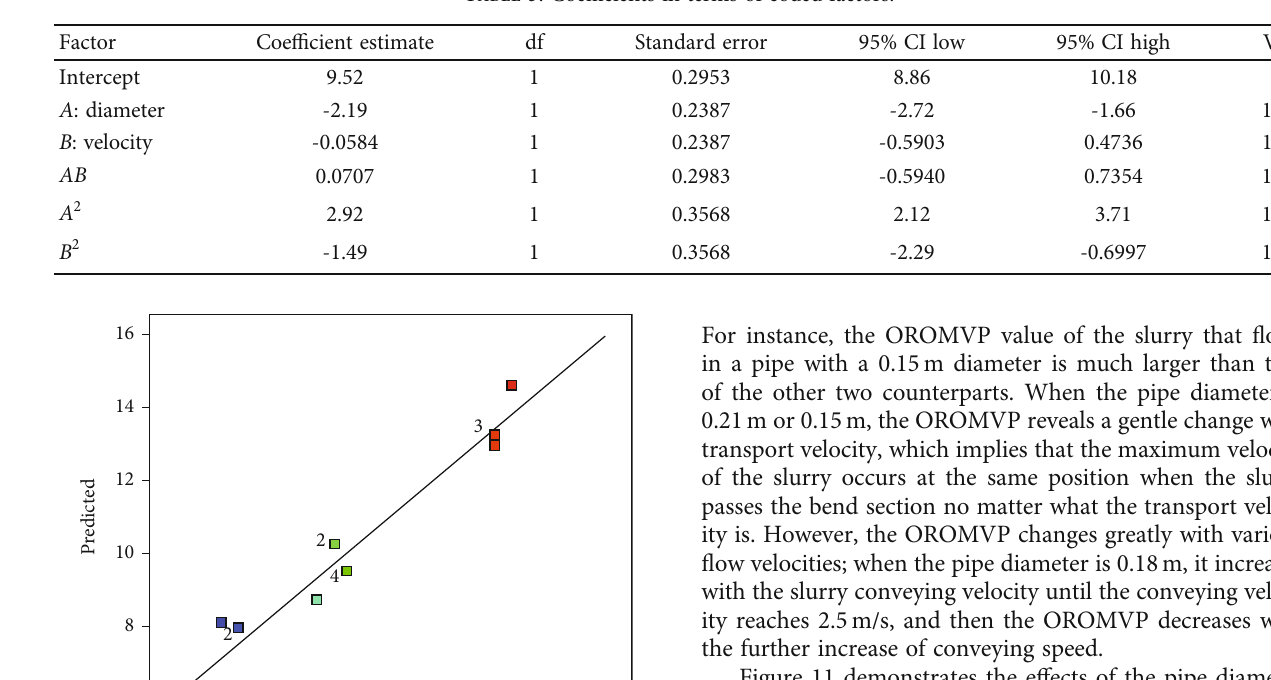
Table 5: Coe ffi cients in terms of coded factors.